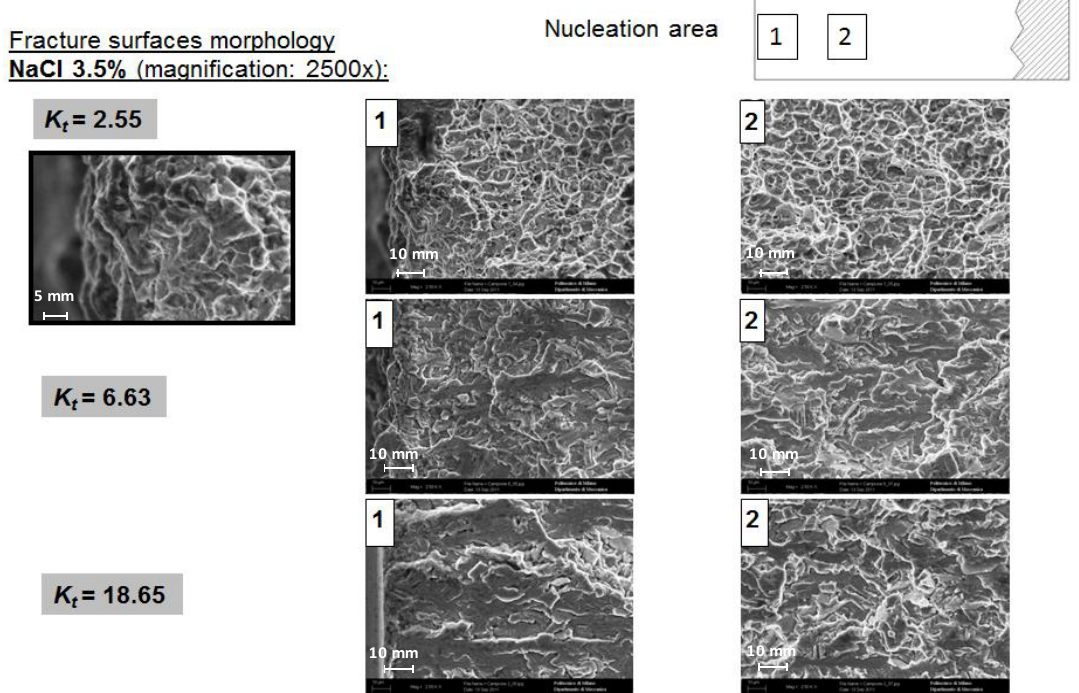
Figure 14. Fracture surface morphology: effect of K